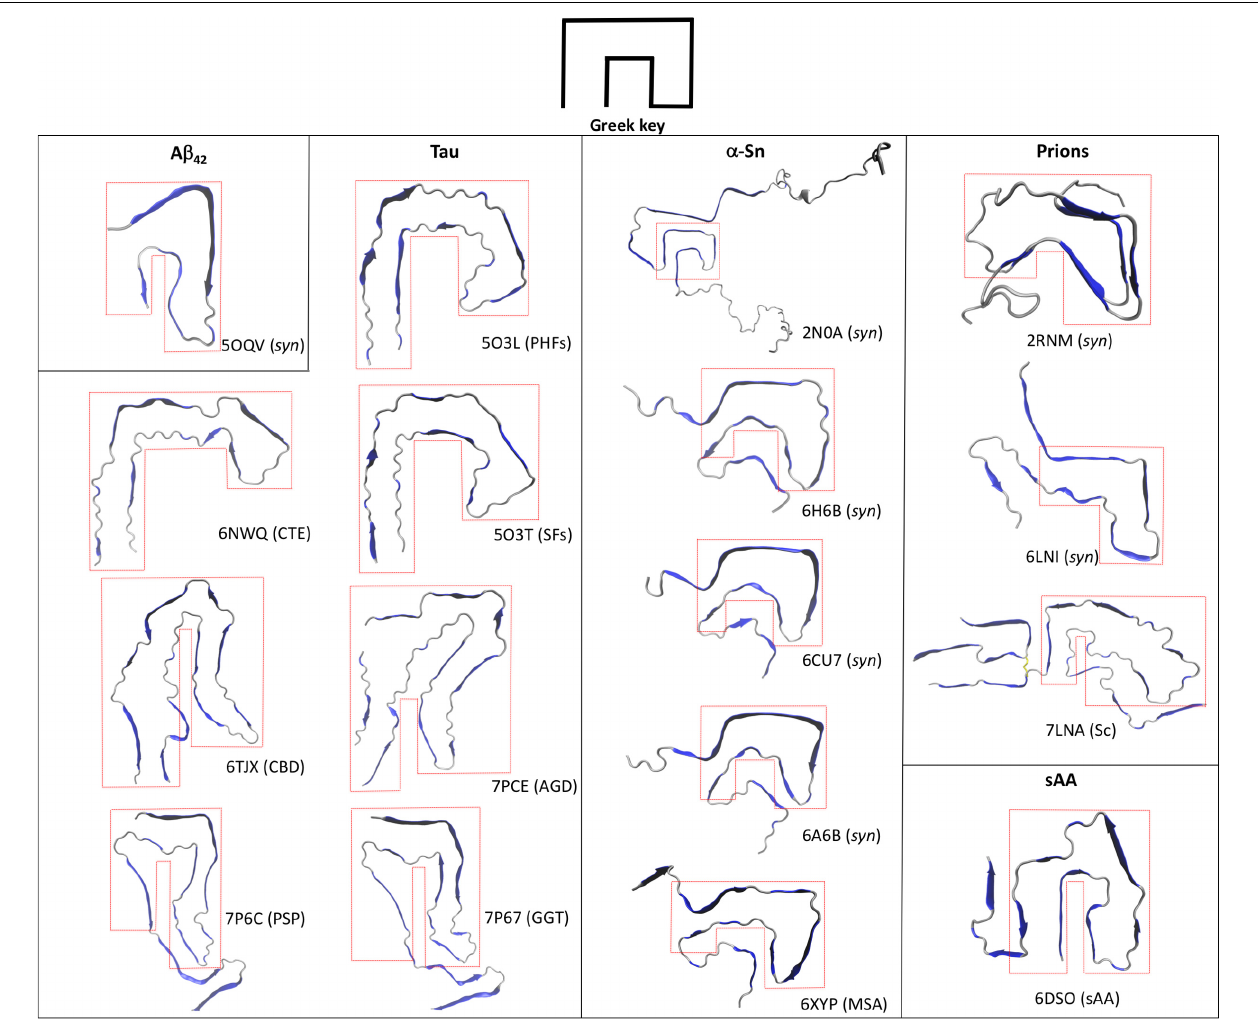
FIGURE 2 | Greek-key topology in the amyloid fold. Top views of the single chains of several amyloid structures of A β 42 , Tau, and α -Sn are shown along with their associated disease or synthetic nature ( syn ). Synthetic HET prion (2RNM), human recombinant prion protein in the amyloid state (6LNI), infectious hamster brain-derived prion protein (7LNA), and mouse spleen-derived acute phase protein serum amyloid A1 (6DSO) are depicted for comparison. The enclosing red dotted lines highlight the Greek-key topology in each